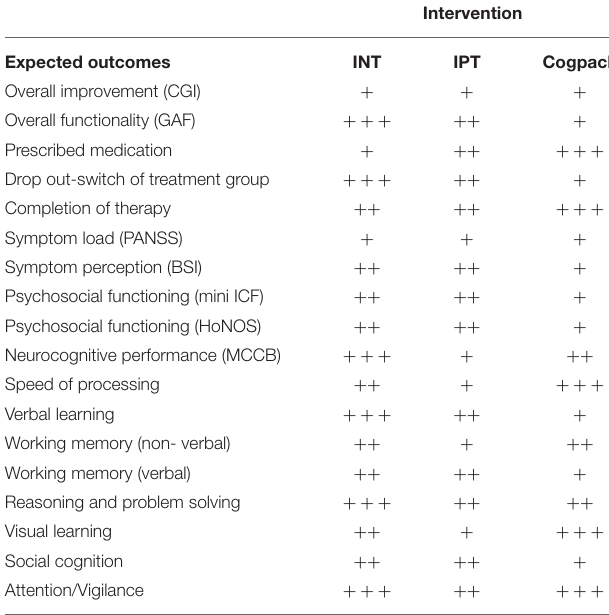
TABLE 4 | Outcome measurements. TABLE 5 | Expected